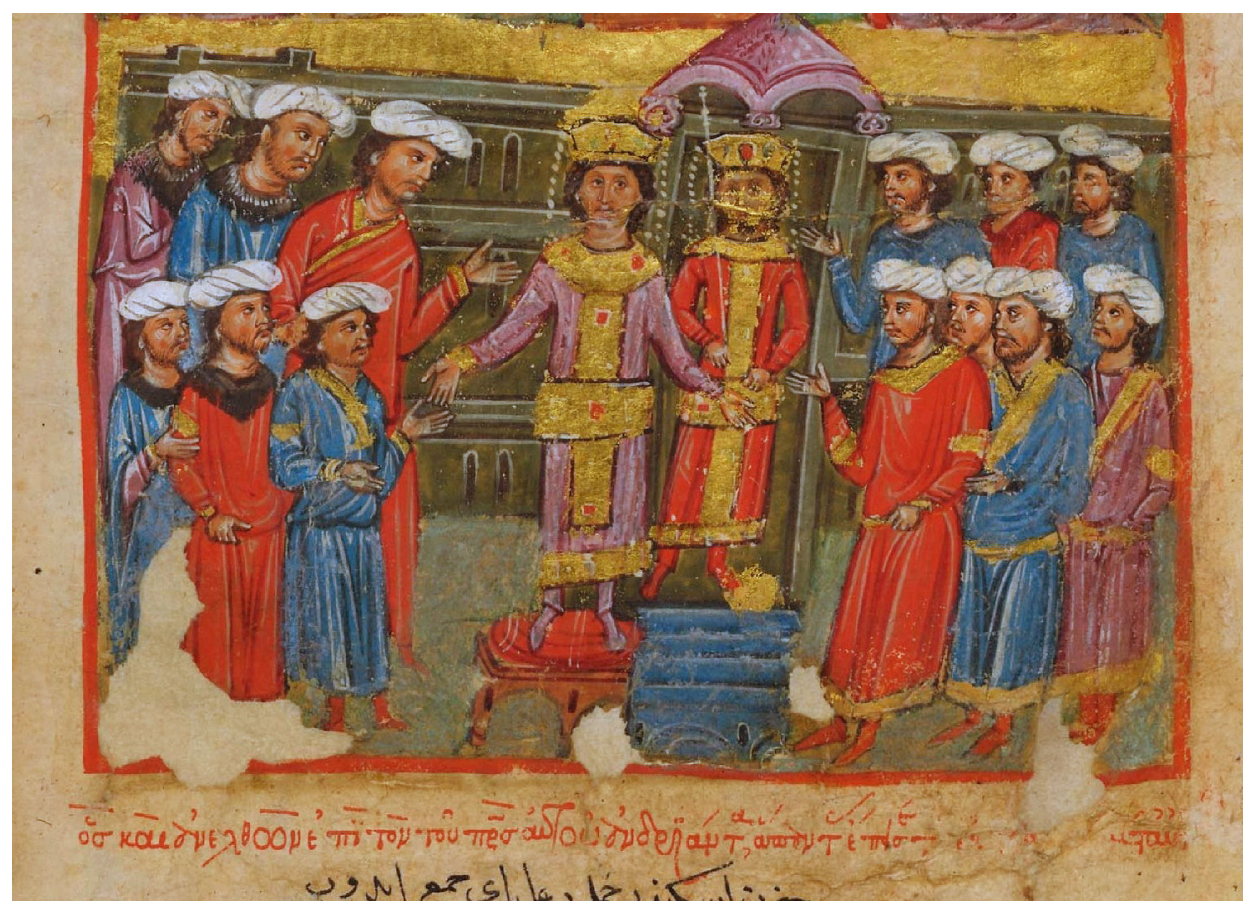
Figure 13. Venice. Istituto Ellenico di Studi Bizantini e Postbizantini cod. 5, fol. 29r (detail). Alexander speaks to the Macedonians beside Philip’s memorial statue. Photo: ©Istituto Ellenico di Studi Bizantini e Postbizantini, Venice, all rights